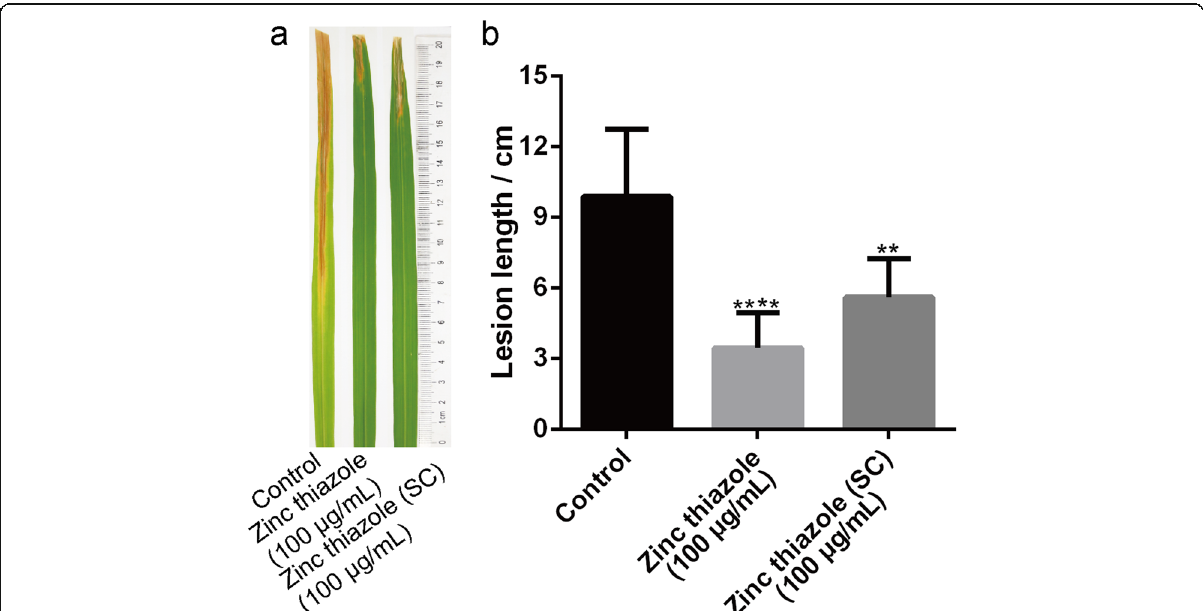
Fig. 7 Curative activities of dissolved zinc thiazole and zinc thiazole SC against rice bacterial blight. a Symptom development of Xoo -inoculated leaves after treatment with dissolved zinc thiazole and zinc thiazole SC: curative test at 7 dpi. Rice leaves were inoculated with Xoo and were sprayed with dissolved zinc thiazole (100 μ g/mL) and zinc thiazole SC (100 μ g/mL) at 12 hpi. Leaves were sprayed with 0.1% DMSO as a control experiment. b Lesion length (cm) of PXO99 in rice leaves treated with 0.1% DMSO, dissolved zinc thiazole and zinc thiazole SC. Error bars represent standard errors from three independent replicates. **: P < 0.01; ****: P <